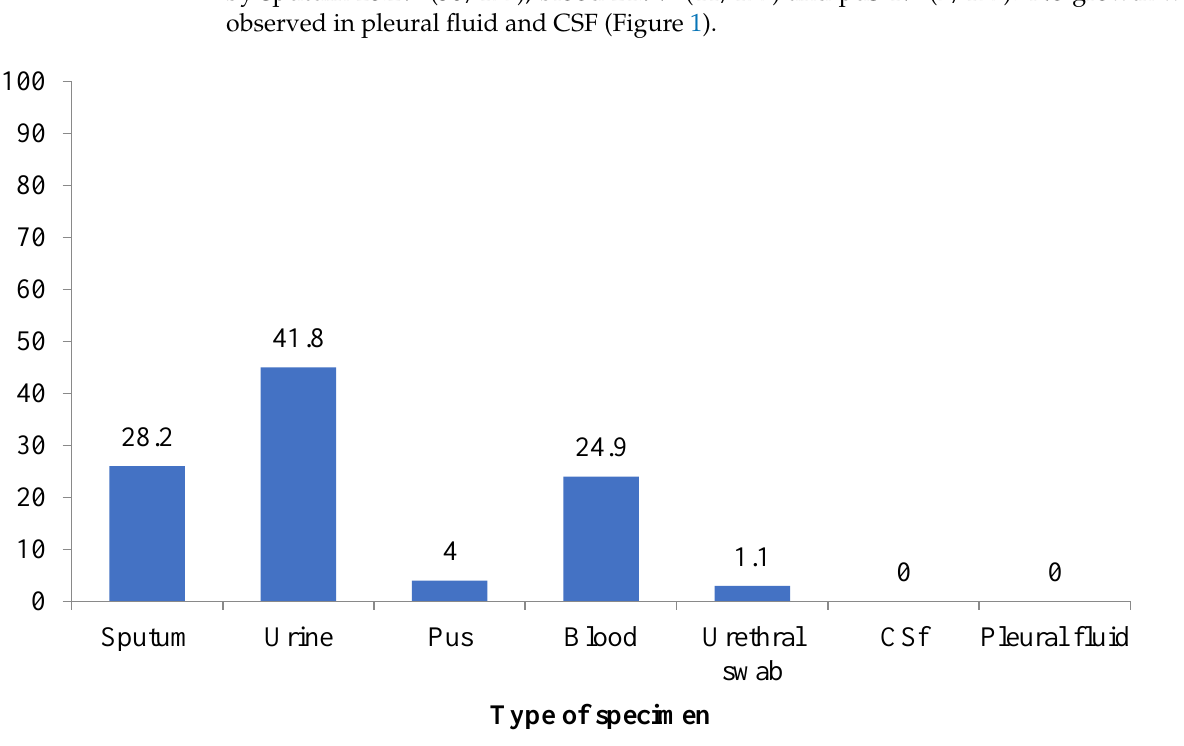
Figure 1. Bacterial growth status in clinical samples.